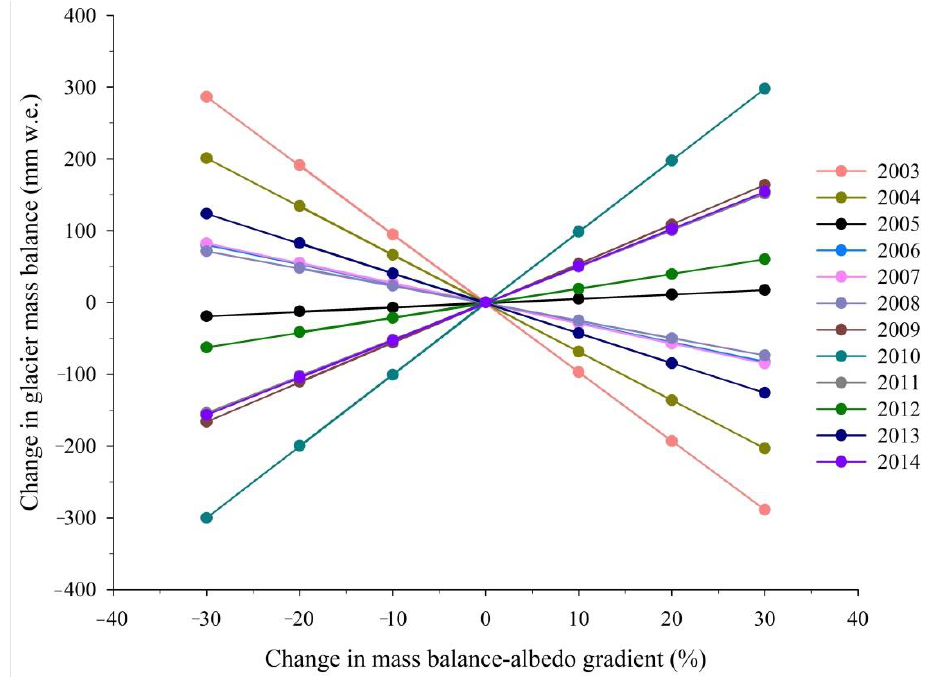
Figure 8. Sensitivity of glacier mass balance (2003 – 2014) to the mass balance – albedo gradient.